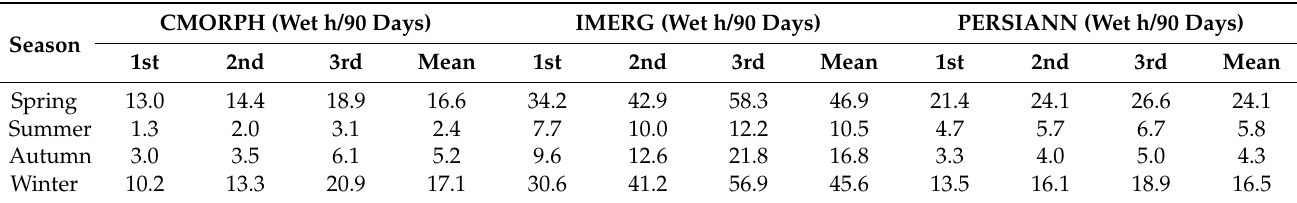
Table 1. Seasonal distribution of the precipitation frequency satellite-based precipitation products (1st quartile, 2nd quartile, 3rd quartile, and the mean).